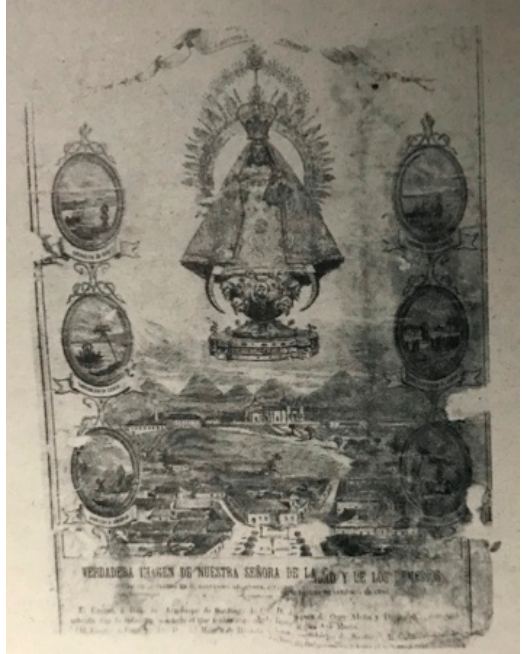
Figure 9. Nuestra Señora de la Caridad y de los Remedios, c. 1792–1823, Cuba. Image reproduced from Olga Portuondo Zúñiga 1995, La Virgen de la Caridad del Cobre: Símbolo de Cubanía (1995). Bishop Osés Alzua (1792–1823), a bishop for Santiago (the eastern region of Cuba),